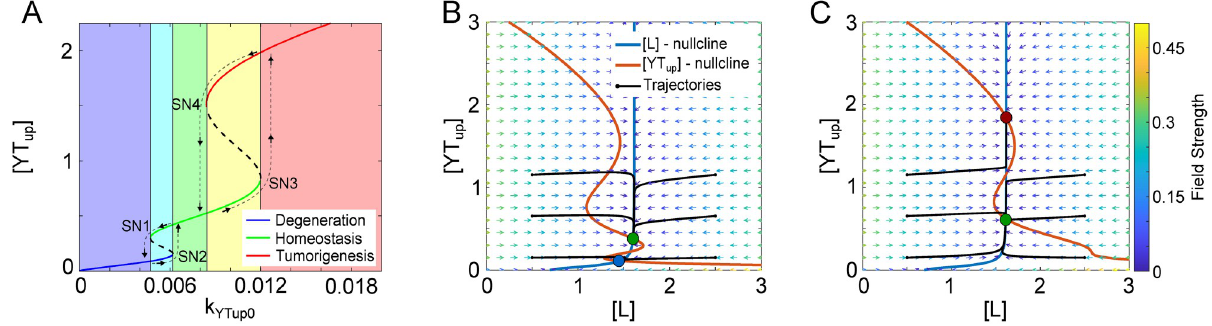
Fig 2. Bifurcation and nullcline analysis displays three states. (A) The bifurcation diagram shows the steady state of active/unphosphorylated YAP/ TAZ as a function of basal expression of unphosphorylated YAP/TAZ ( k ). The labeled points SN1, SN2, SN3, and SN4 indicate saddle-node YTup 0 bifurcation points. The black dashed lines represent the unstable steady states while the solid colored lines represent the steady states. The lower blue branch, middle green branch, and upper red branch are defined as the degenerative state, homeostatic state, and tumorigenic state, respectively. The green shaded region shows the monostable range within the homeostatic state, the blue shaded region shows monostable range within the degenerative state, and the red shaded region shows the monostable range within the tumorigenic state. The cyan shaded region shows a bistable region with degenerative and homeostatic states, while the yellow shaded region shows the bistable region with the homeostatic and tumorigenic states. (B) Nullcline analysis of the regulatory system shows the two stable steady states and one unstable steady state when k YTup 0 is within the first bistable region (between SN1 and SN2). Example trajectories starting from different initial conditions were shown to represent the dynamics of the system towards the tissue homeostatic and degenerative states. (C) Nullcline analysis of the regulatory system shows the two stable steady states and one unstable steady is within the second bistable region (between SN3 and SN4). Example trajectories (black solid lines) starting from different initial state when k YTup 0 conditions were shown to represent the dynamics of the system towards the tissue homeostatic and tumorigenic